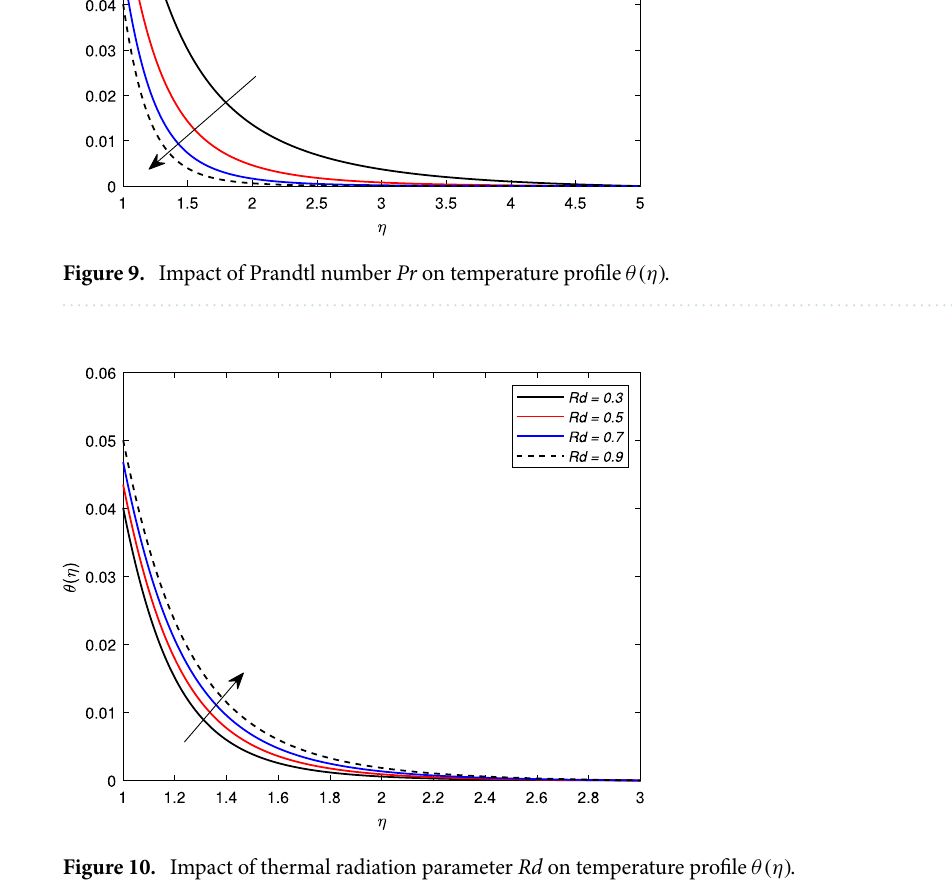
Figure 10. Impact of thermal radiation parameter Rd on temperature profile θ(η)